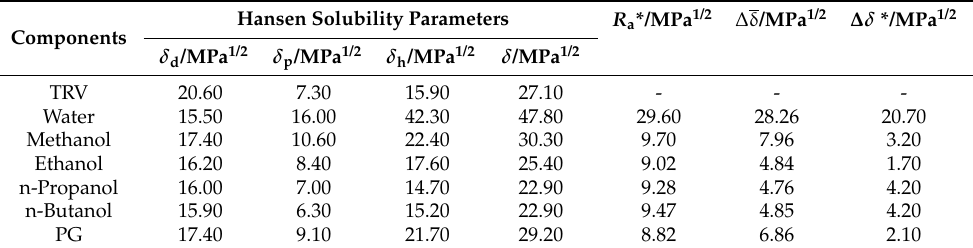
Table 3. Various solubility parameters of TRV and six different mono-solvents at 298.2 K. Components